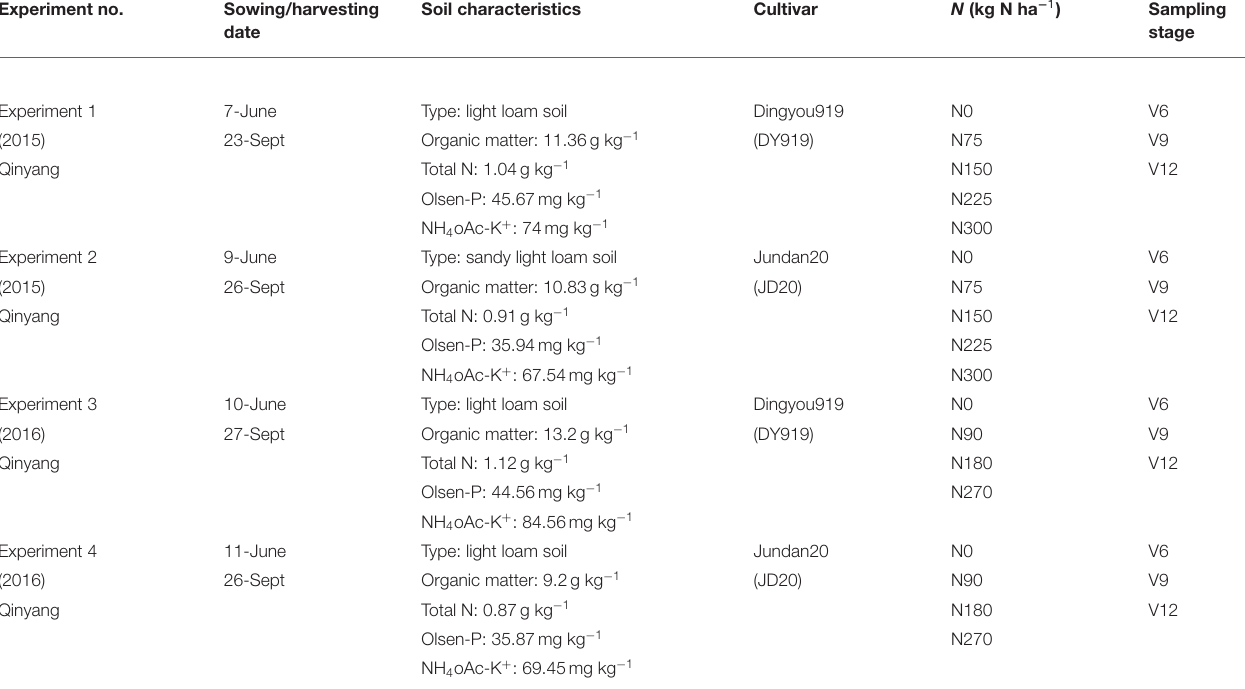
TABLE 1 | Basic information about the four field experiments conducted during the 2015 and 2016 growing seasons at Qinyang. Experiment no.